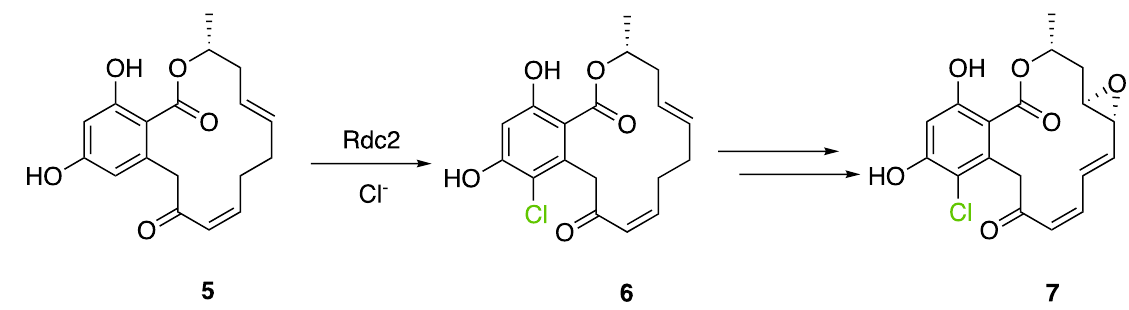
Figure 12. ( R )-Monocillin II ( 5 ) chlorination by Rdc2 to form pochonin D ( 6 ), precursor of radicicol ( 7 ).